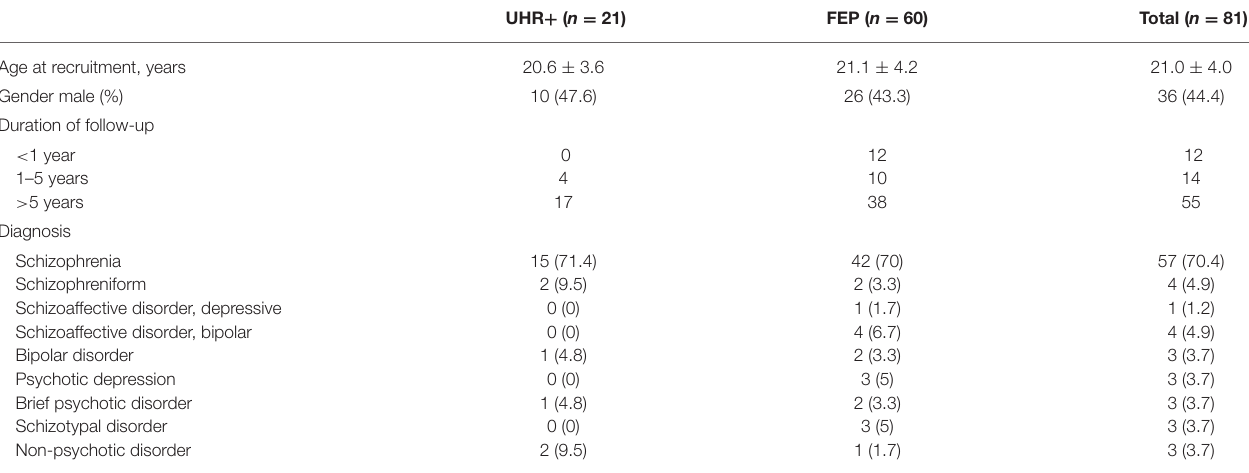
TABLE 1 | Summary of demographic and clinical features of the original cohort.